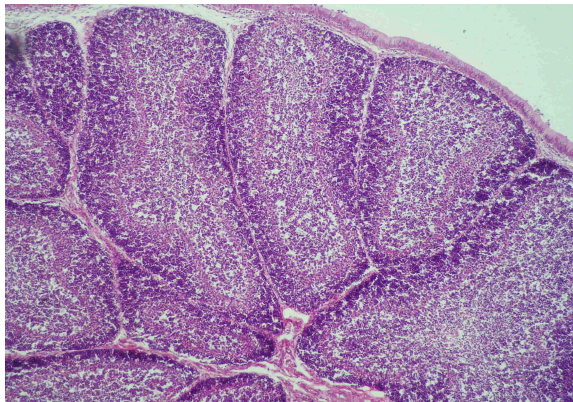
Fig. 5. Broiler chicken’s Bursa of Fabricius, the 1 st